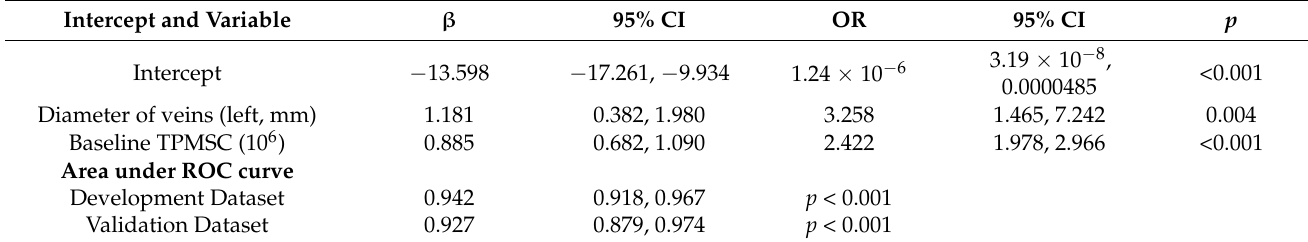
Table 3. Multivariate binary logistic regression of semen parameter improvement after MSV.